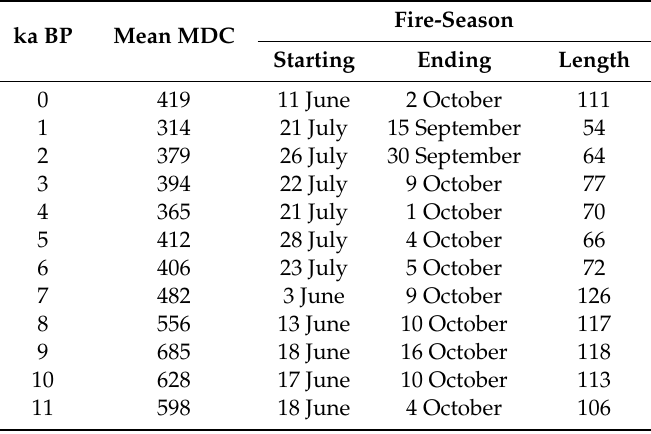
Table 2. Holocene characteristics in terms of summer fire hazard and fire-season length computed using HadCMB3-M1 simulation datasets